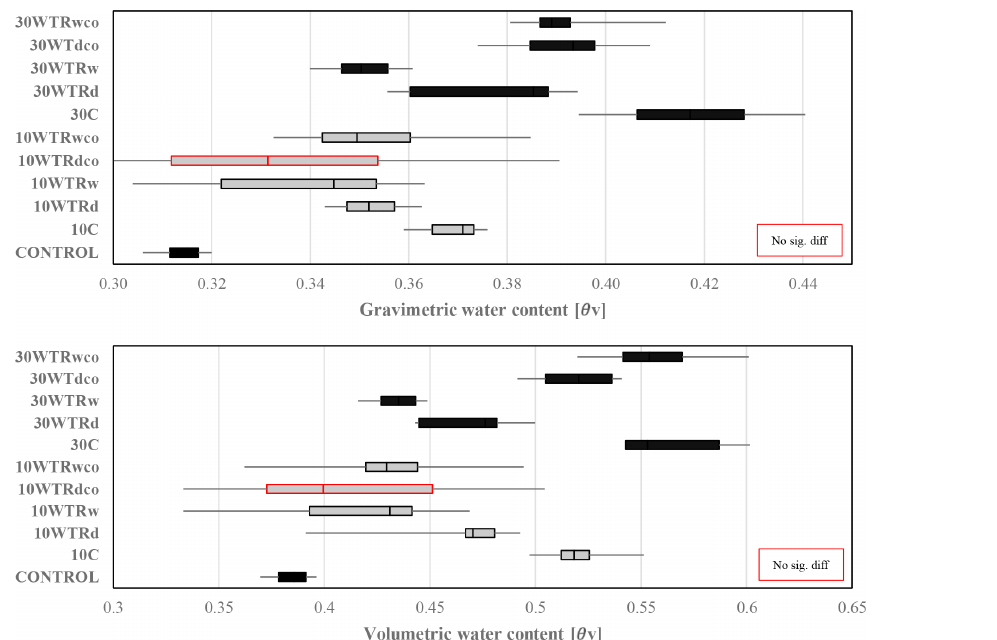
Figure 2. Box plot of maximum gravimetric water content ( θ g ) and volumetric water content ( θ v ) of specimens at saturation after second flooding